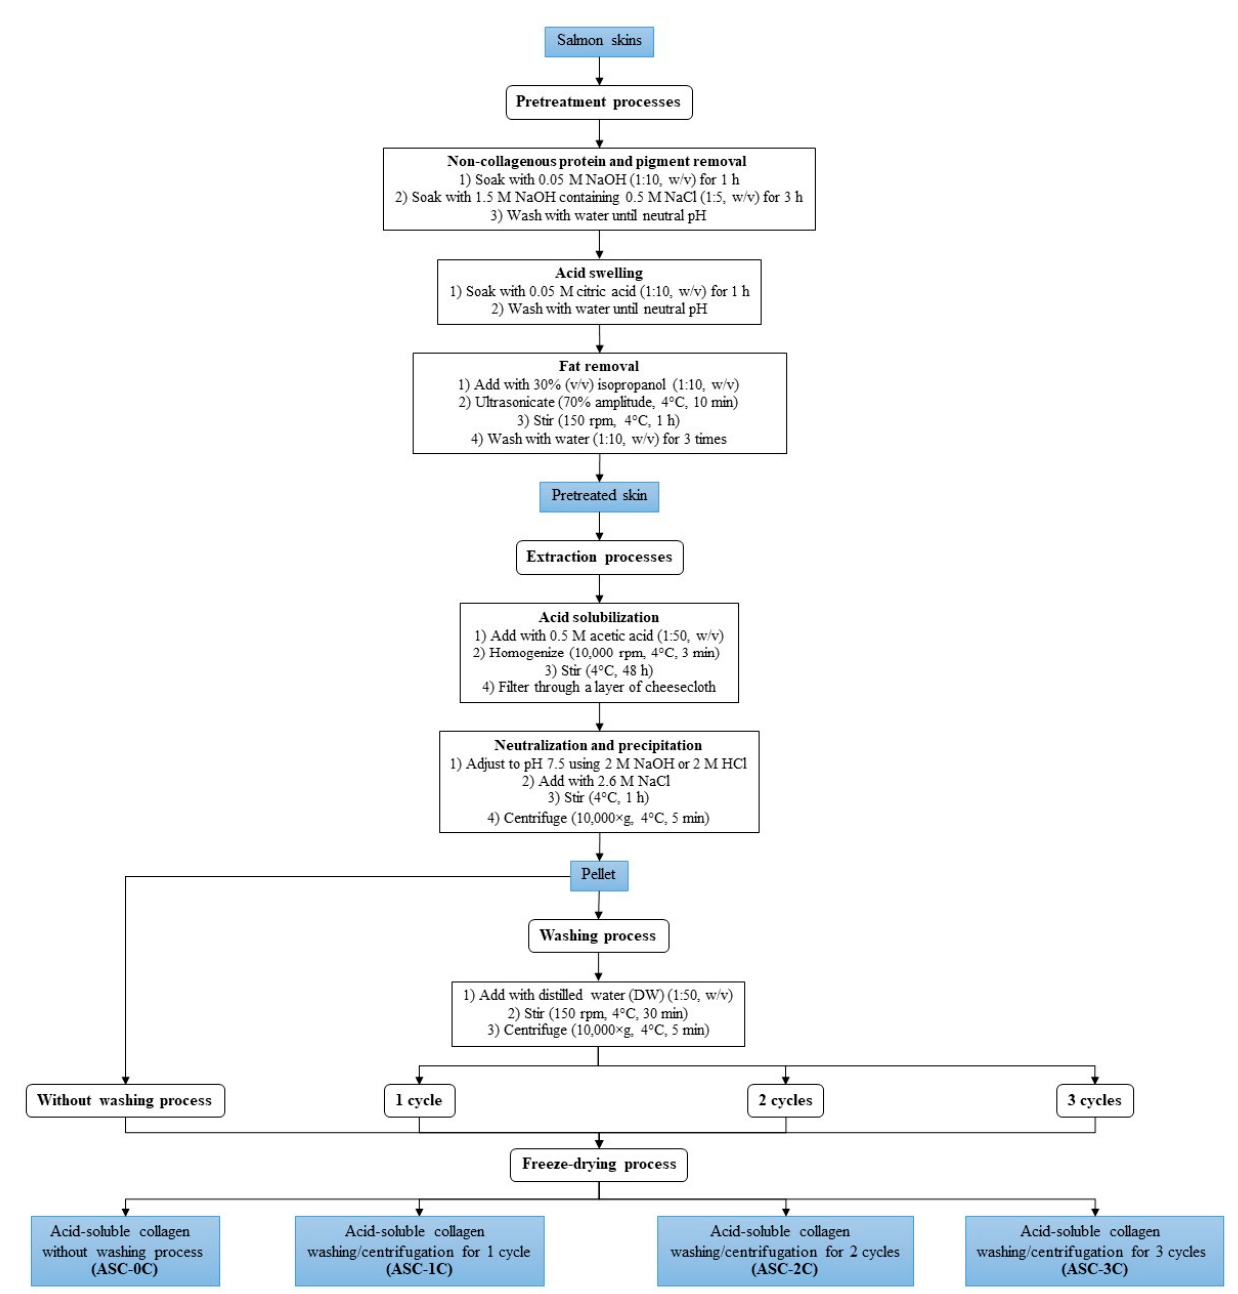
Figure 1. Schematic diagram for simplified recovery method of acid-soluble collagen from salmon skin.